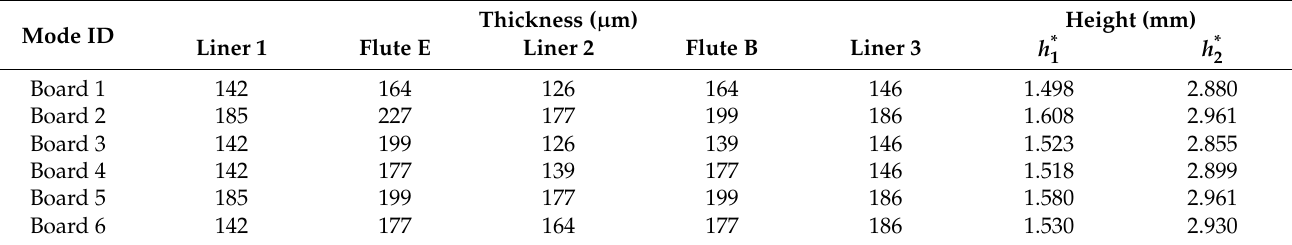
Table 3. Thickness of individual layers of corrugated board and height of corrugated layers.